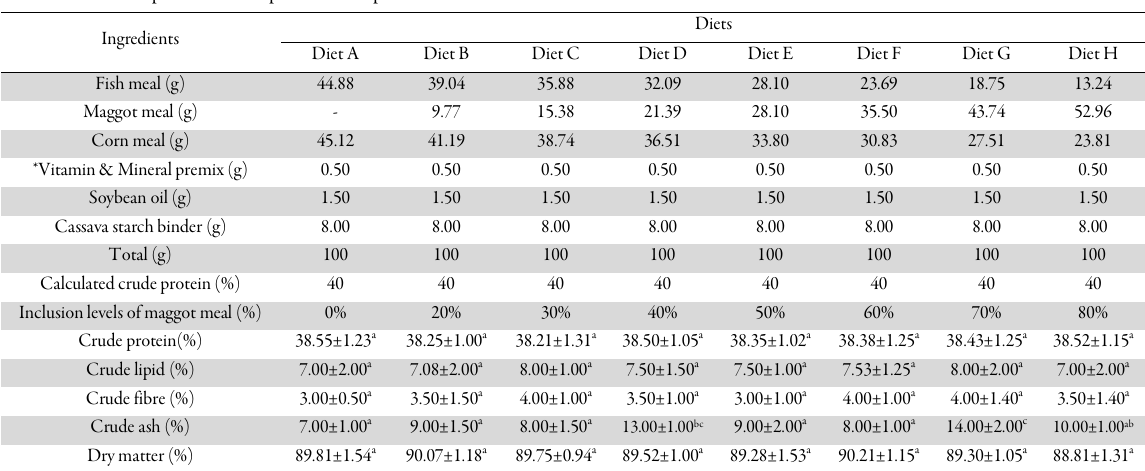
Table 2. Gross and proximate composition of experimental diets